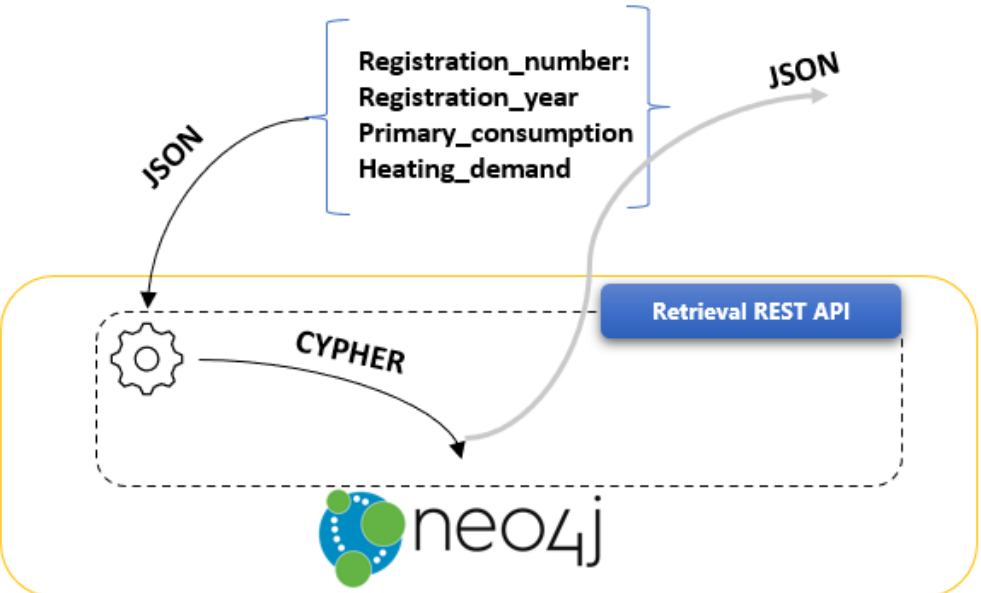
Figure 5. Data flow in the Reasoning Engine retrieval REST API.